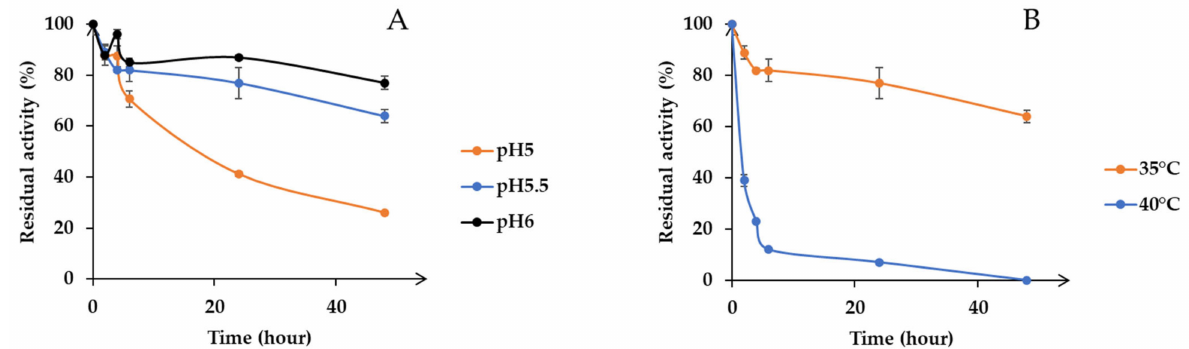
Figure 4. pH and temperature stability. ( A ) pH stability in 50 mM citrate-phosphate buffer from pH 5 to 6 at 35 ◦ C; ( B ) Temperature stability from 35 ◦ C to 50 ◦ C at pH 5.5. Activity values were calculated as a percentage of maximum activity (set to 100%) at optimum temperature and pH. Each data point (mean +/ − standard deviation) is the result of triplicate experiments.